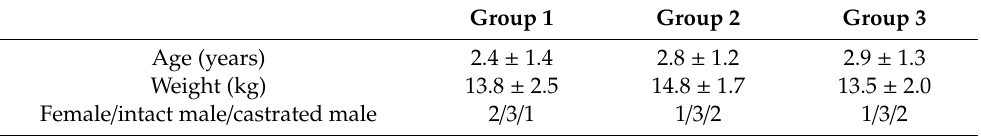
Table 1. Age, weight and sex of dogs in the di ff erent experimental groups.